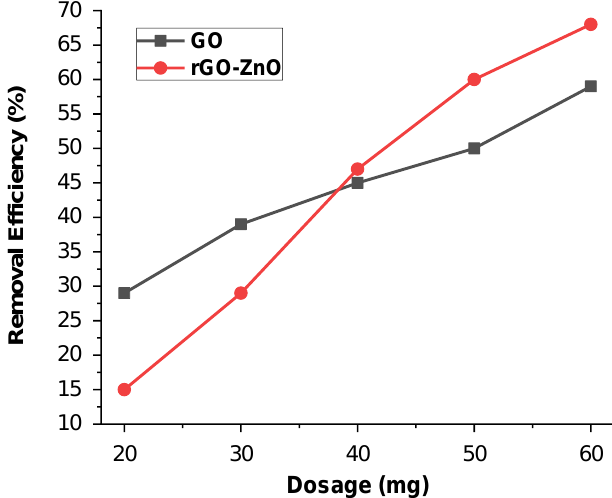
Figure 9. The effect of the mass on % removal of Cr